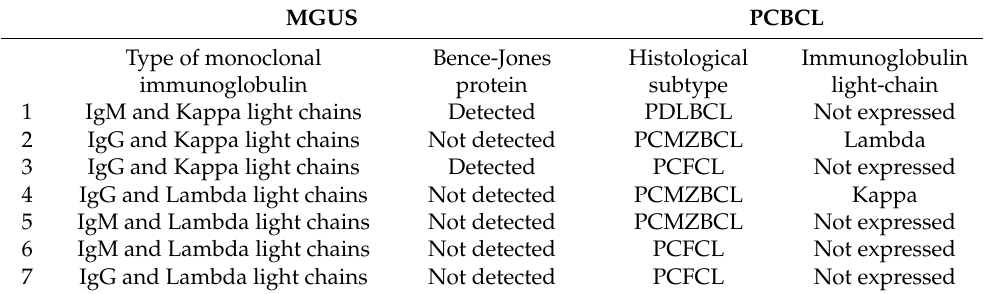
Table 3. Immunophenotype and histological correlations in subjects with MGUS and PCBCL.